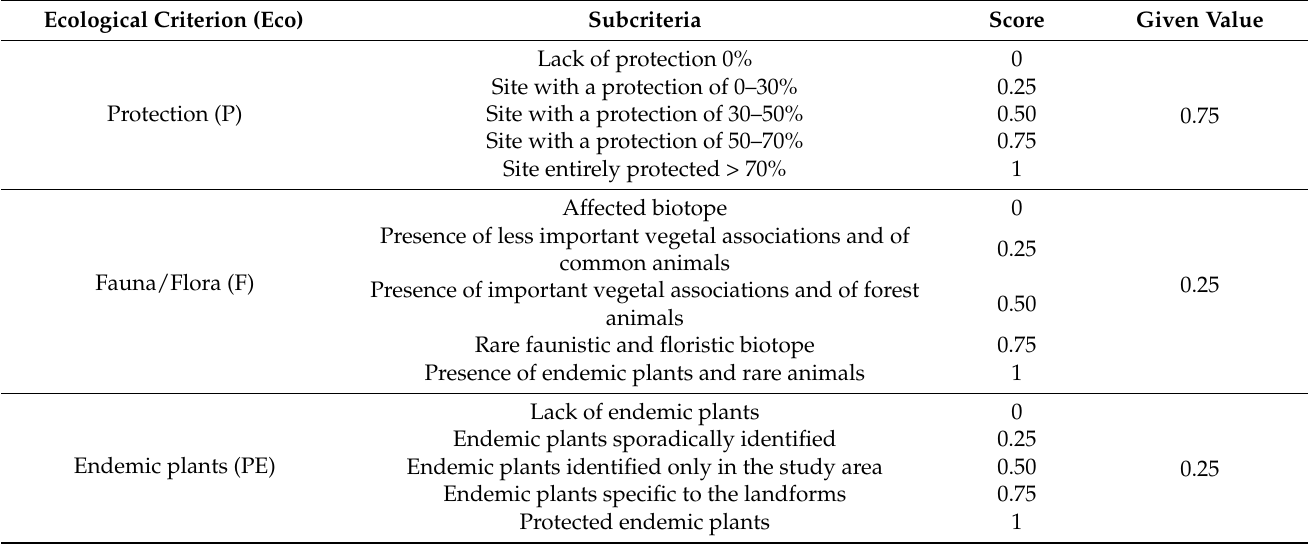
Table 2. Geomorphological value—the ecological criterion (Eco).